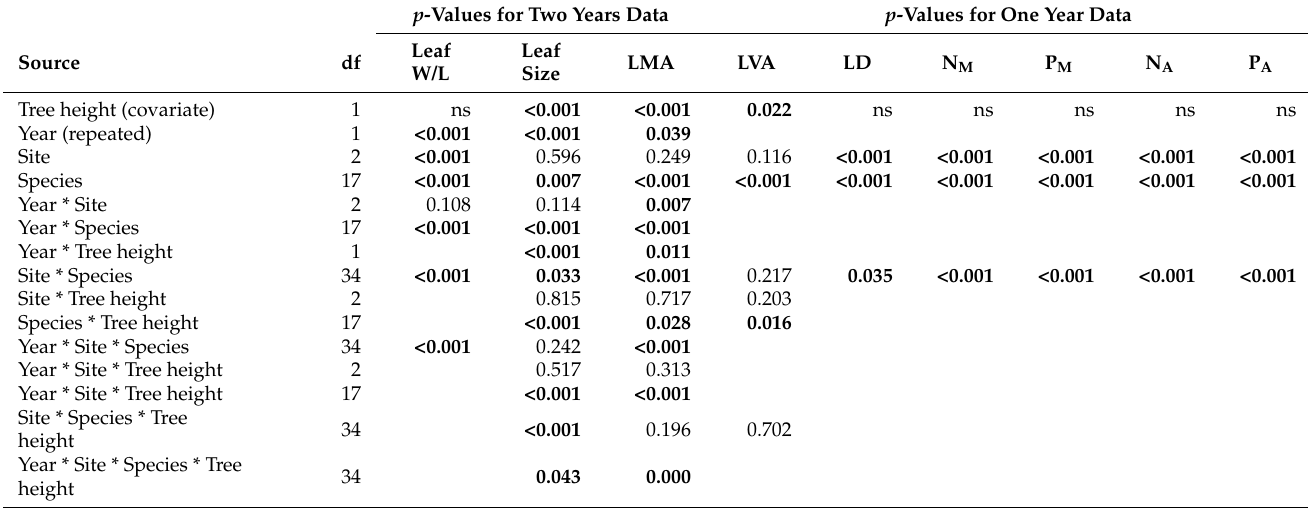
Table 4. p -values for effects of year, site and species, and for leaf width-to-length ratio (W/L), leaf size, leaf mass per area unit (LMA) and effects of site, species for leaf volume per unit area (LVA), leaf density (LD) and leaf nitrogen per unit mass (N M ) and area (N A ), and leaf phosphorus per unit mass (P M ) and area (P A ). Tree height was used as covariate when significant (Table S3). df represents degree of freedom. p -Values for Two Years Data p -Values for One Year Data